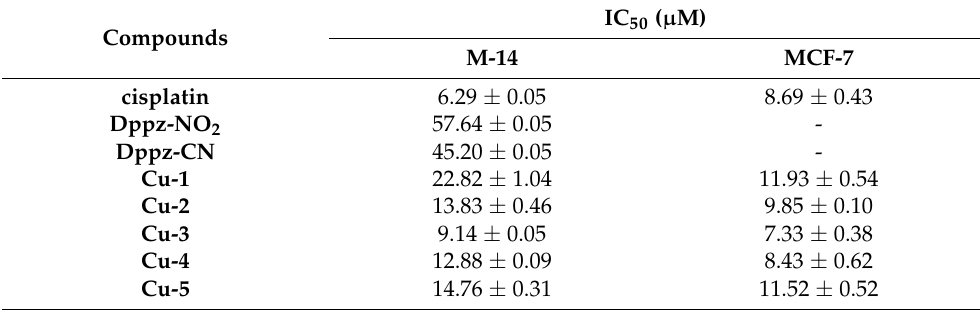
Table 3. Anticancer Activities of the Copper Complexes and Cisplatin Against M-14 and MCF-7 Cell